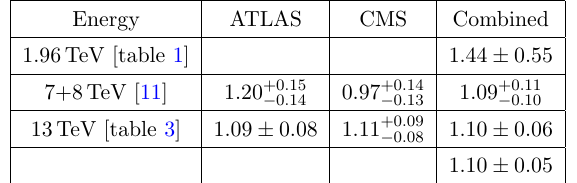
Table 4 . Combined average signal strengths for the Tevatron at 1.96 TeV, and for ATLAS and CMS at 7 + 8 TeV and 13